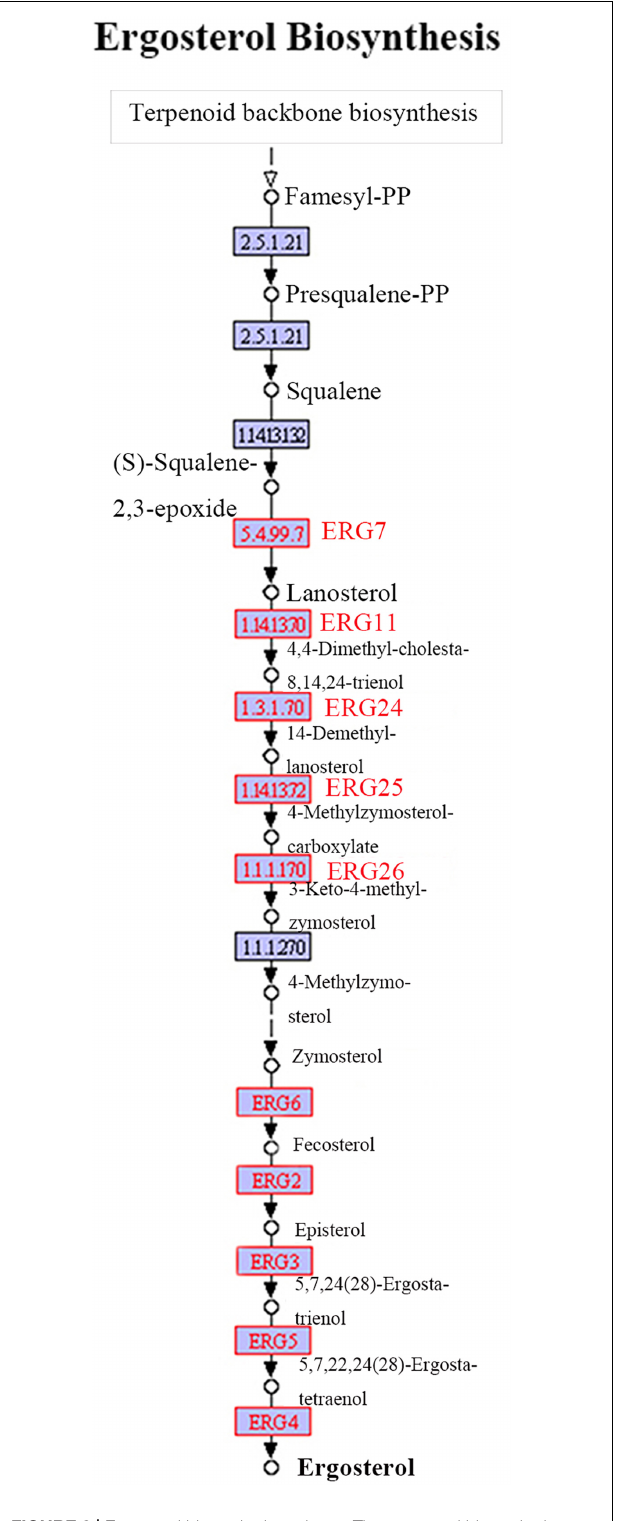
FIGURE 3 | Ergosterol biosynthetic pathway. The ergosterol biosynthetic pathway from Terpenoid backbone to ergosterol has been shown. The words in red represent DEGs up-regulated in the QR group, compared to that of the control